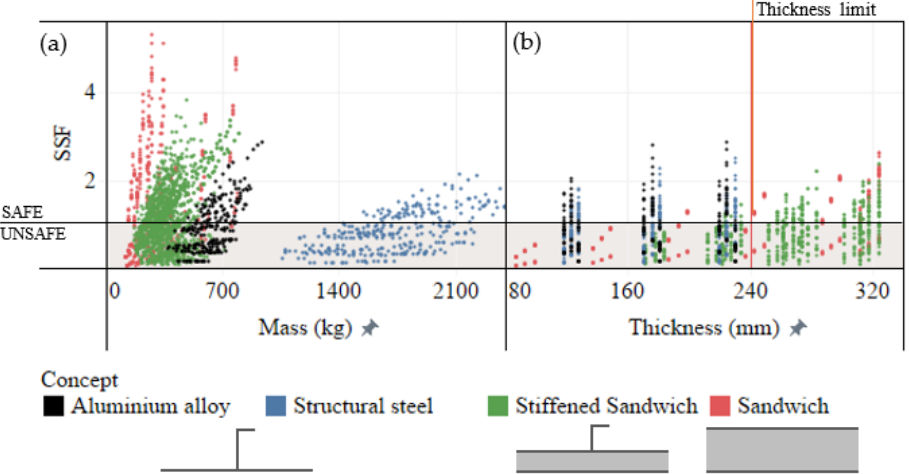
Figure 7. Comparison of stress safety factors with respect to ( a ) mass and ( b ) panel thickness for all structural concepts.